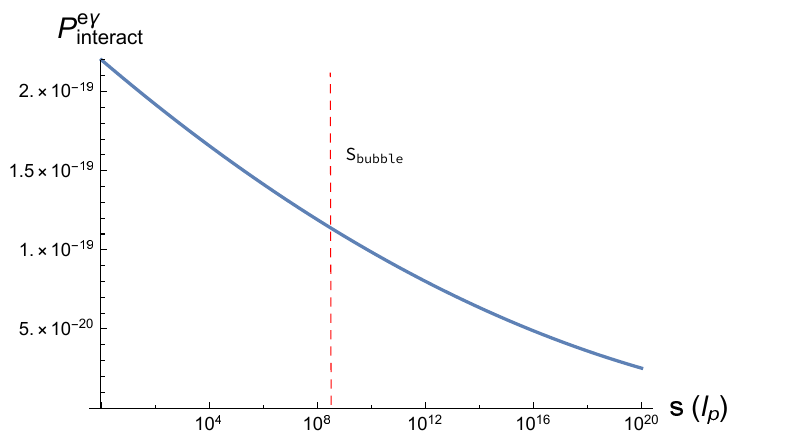
Figure 2 . The probability P e(cid:13) for an infalling electron to interact with photons in the radiation. interact The electron is taken to fall into a solar mass hole, starting from rest at in(cid:12)nity. The horizontal axis gives the distance s from the horizon in planck units. We see that P e(cid:13) remains small all interact the way from in(cid:12)nity to the location s bubble